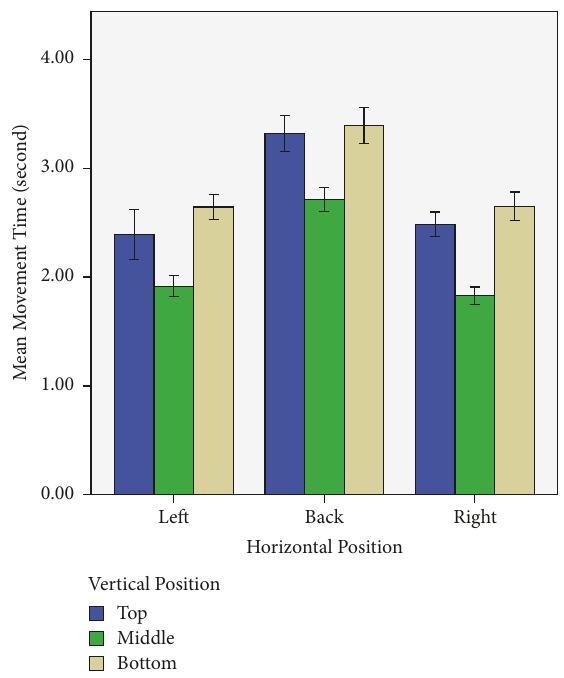
Figure 8: Mean movement time for Horizontal Position × Vertical Position (all error bars in this and following charts represent 95% confidence